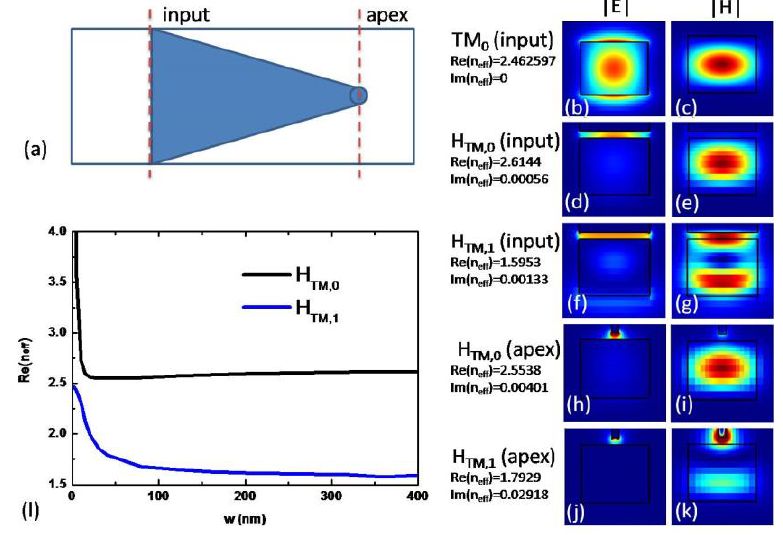
Figure 2. ( a ) The concerned sites (input and apex as marked by red dashed lines) in the mode analysis to the plasmonic memristor; ( b ) electrical field and ( c ) magnetic field profile of the TM mode inputted from Si waveguide; ( d ) electrical field and ( e ) magnetic field profile of the H TM, 0 mode exited at the input of the taper (w = 400 nm); ( f ) electrical field and ( g ) magnetic field profile of the H TM, 1 mode exited at the input of the taper (w = 400 nm); ( h ) electrical field and ( i ) magnetic field profile of the H TM, 0 mode propagated to the apex of the taper (w = 40 nm); ( j ) electrical field and ( k ) magnetic field profile of the HTM, 1 mode propagated to the apex of the taper (w = 40 nm); ( l ) mode effective indices of H TM, 0 and H TM, 1 modes as the function of the width at different sites of silver taper. As specified for the H TM, 0 and H TM, 1 modes, the beat length (BL), given by the length over which the relative phase of the super modes differs by 2 π , is inversely